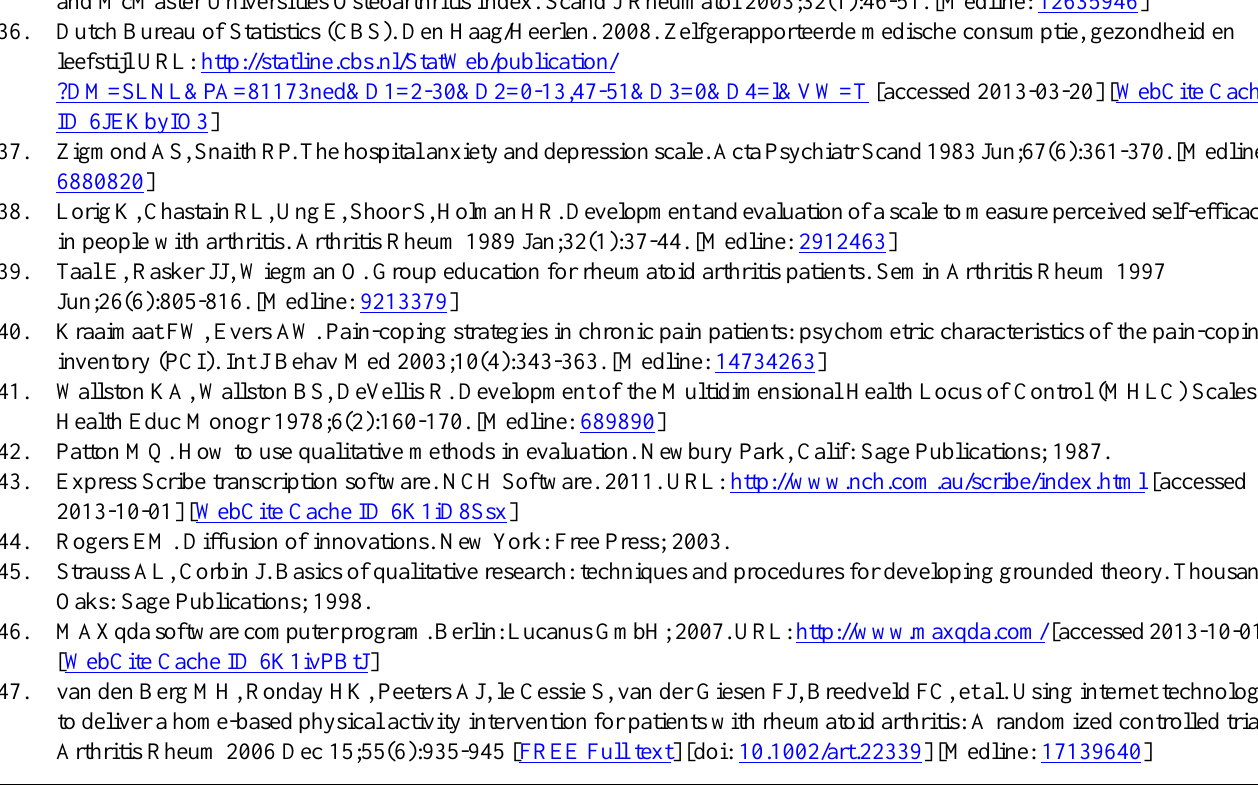
Abbreviations BGA: behavior graded activity BMI: body mass index HOOS: Hip Injury OA Outcome Score KOOS: Knee OA Outcome Score MHLC: Multidimensional Health Locus of Control